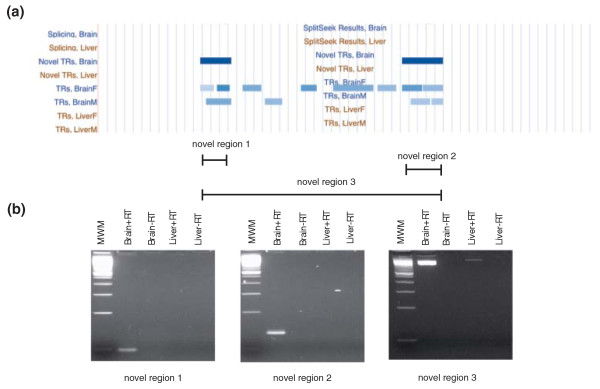
Example of an intergenic novel transcript that was absent in the human genome. (a) A view from the UCSC Genome Browser showing an intergenic region on chromosome 1. Two novel TRs are shown as blue boxes and the position of primers and the experimentally validated fragments are indicated with lines. (b) Results of the experimental validation with RT-PCR. The first two gels show fragments covering the two novel TRs and the third gel is a fragment spanning the junction between the novel TRs. The first lane on the gels is a 100-bp ladder (molecular weight marker, MWM), then follows the brain sample with (+RT) and without (-RT) reverse transcriptase, followed by the same set of experiments in the liver sample.